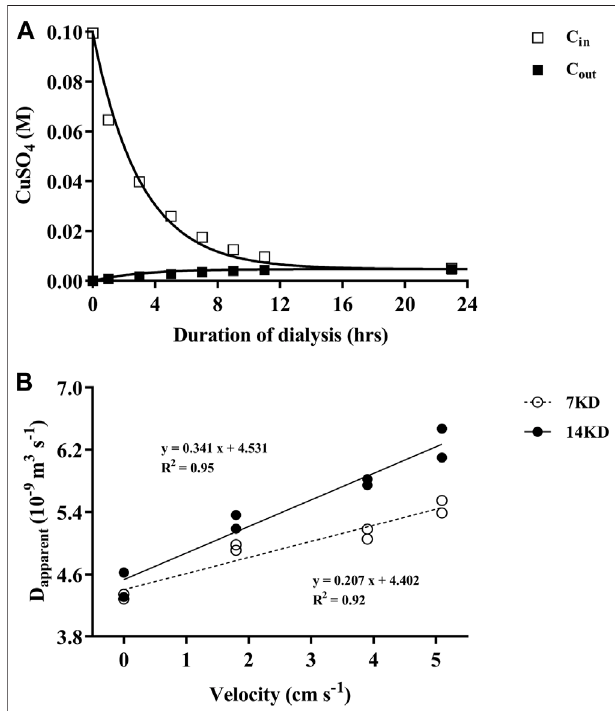
FIGURE 1 | (A) The changes of CuSO 4 concentrations within (C in ) and outside (C out ) of the dialysis bags over time, with the curves representing the predicted and the squares the measured values. (B) Relationship of the